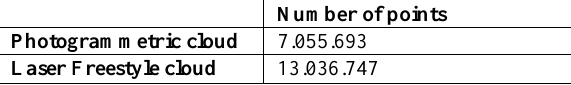
Table 1. Comparison between densities of different clouds.